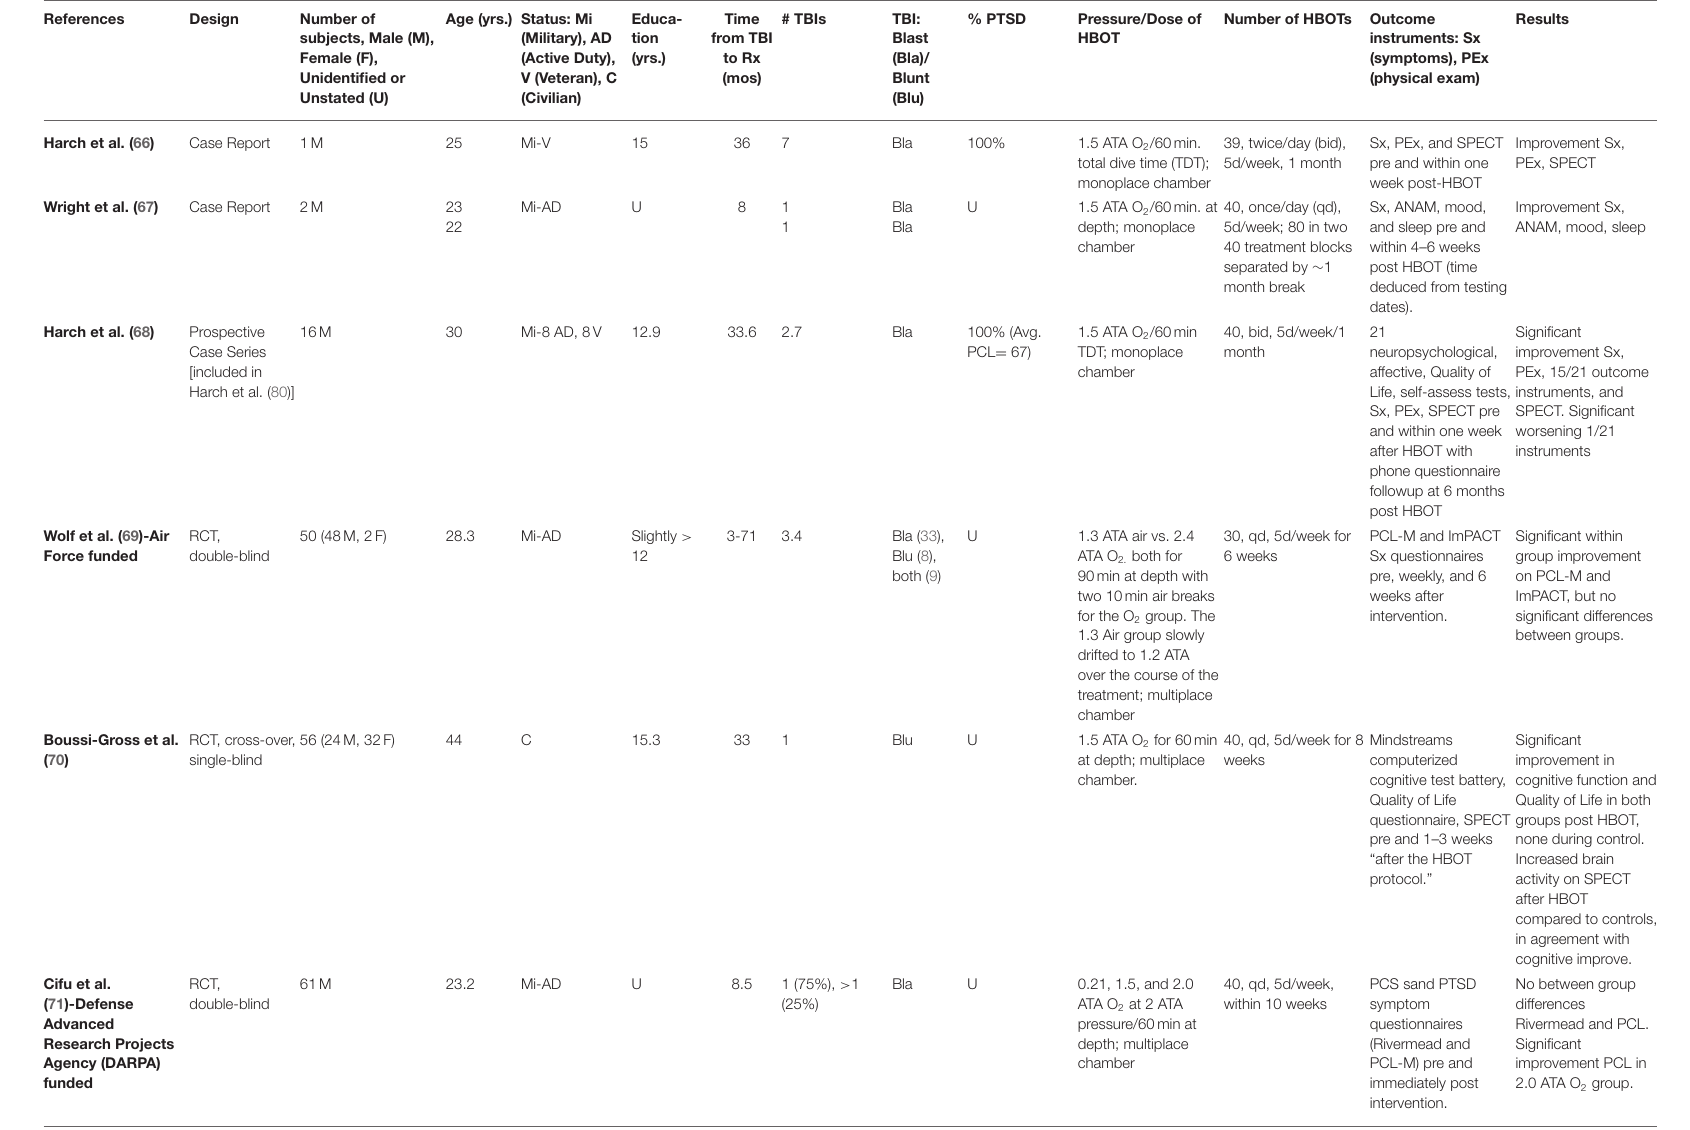
TABLE 1 | Retrieved analyzed studies and companion